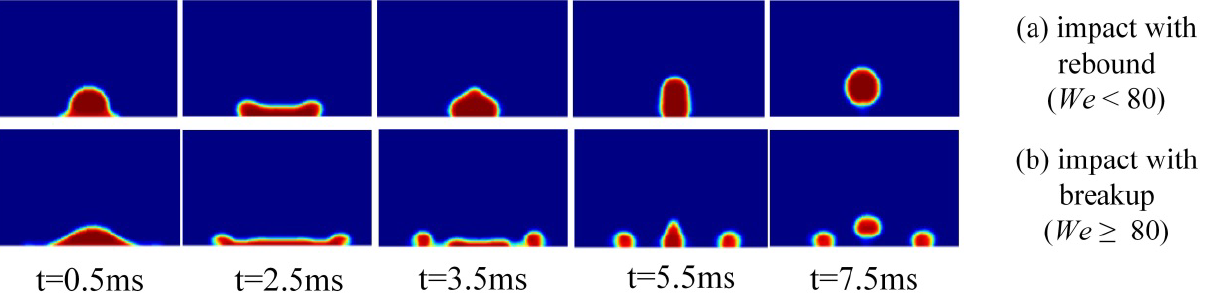
Figure 5. Two regimes of simulated outcomes of droplet impact on hot surface ( D 0 = 1 mm and T s = 573 K).